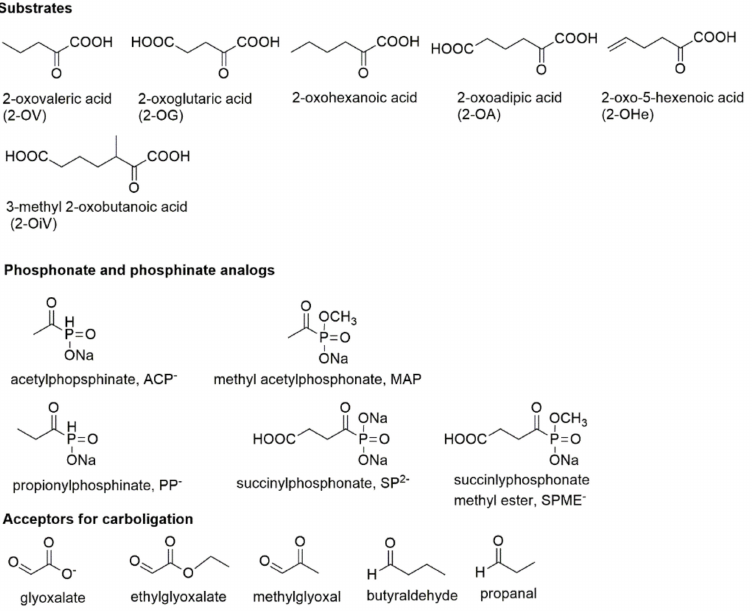
Figure 2. Structures of the substrate analogues ( top ), of the pre-decarboxylation intermediate ( middle ) and different aldehyde acceptors employed in the carboligation reaction